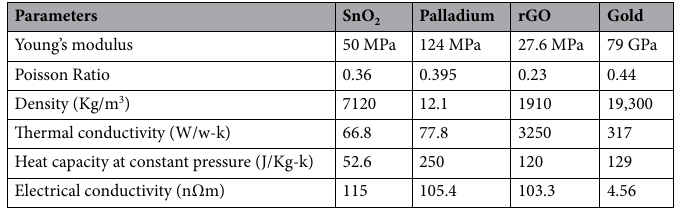
Table 2. Properties of materials.